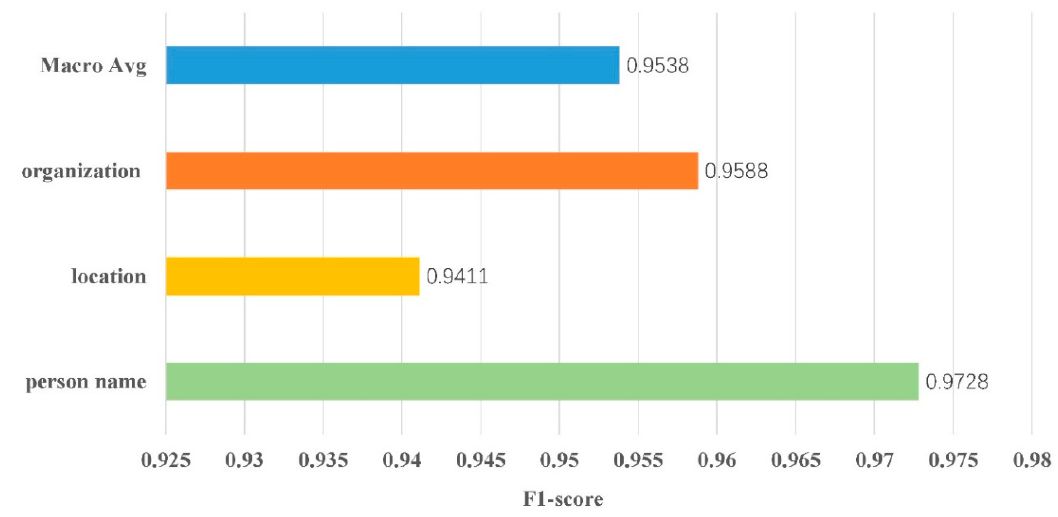
Figure 6. Statistical recognition results on the People’s Daily Ner Corpus.